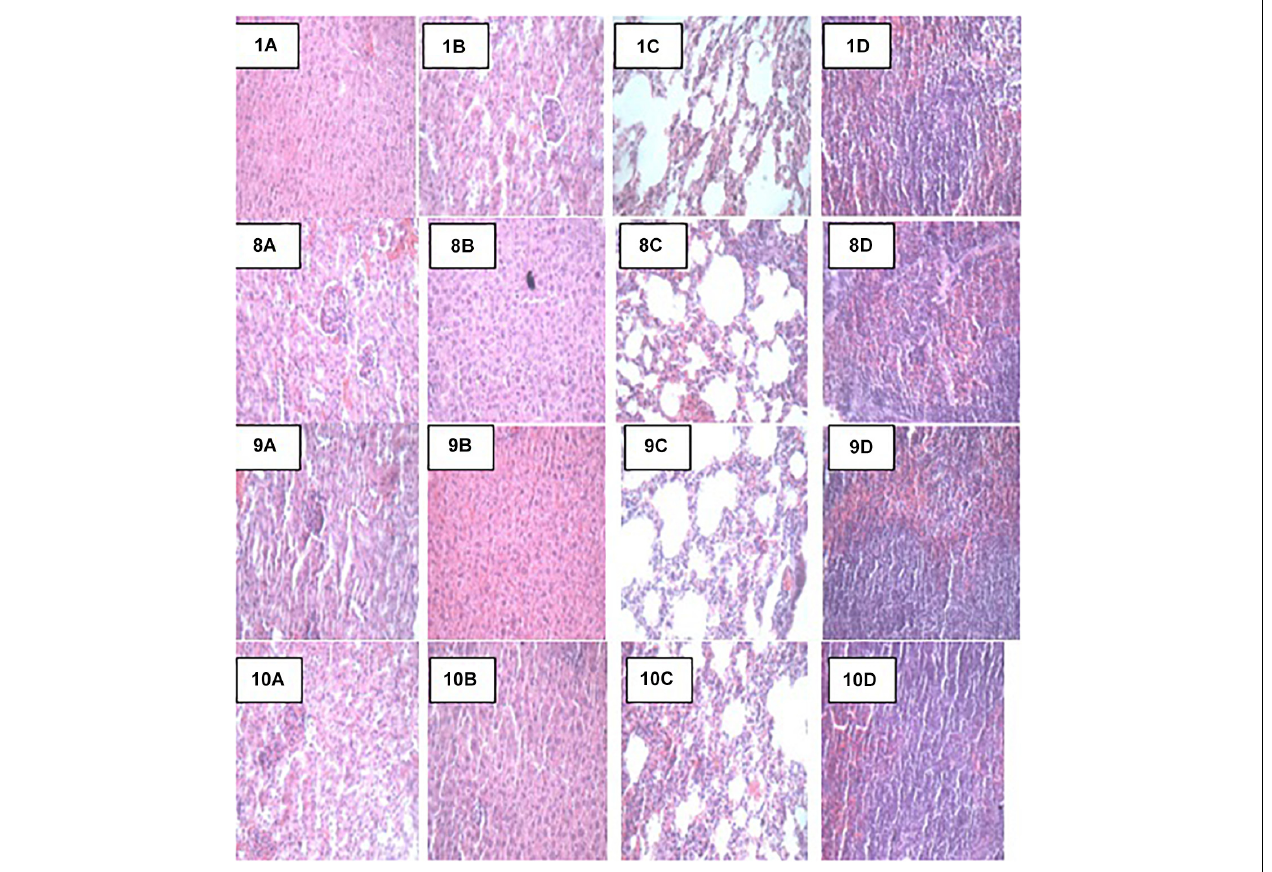
FIGURE 3 | Representative photomicrographs of organs of mice fed Control, T EC , T STEC and T LBEC diets 1A–1D : Control (Kidney, liver, lung, and spleen, respectively), 8A–8D : T EC (Kidney, liver, lung, and spleen, respectively), 9A–9D : T STEC (Kidney, liver, lung, and spleen, respectively), and 10A–10D : T LBEC (Kidney, liver, lung, and spleen,